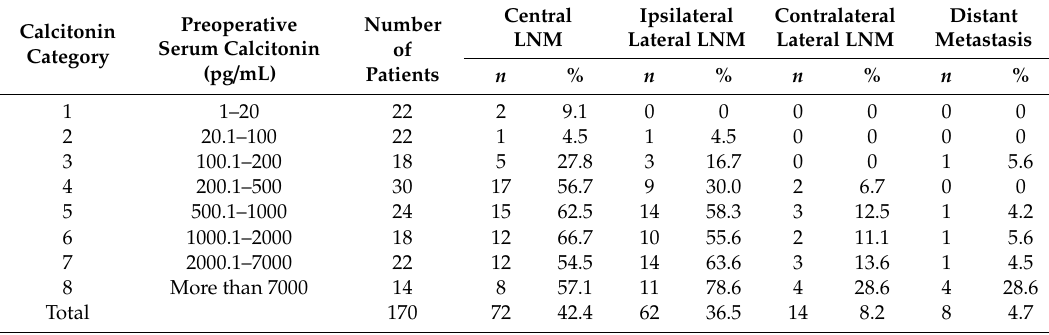
Table 4. Lymph node metastasis and distant metastasis by preoperative serum calcitonin levels. Calcitonin